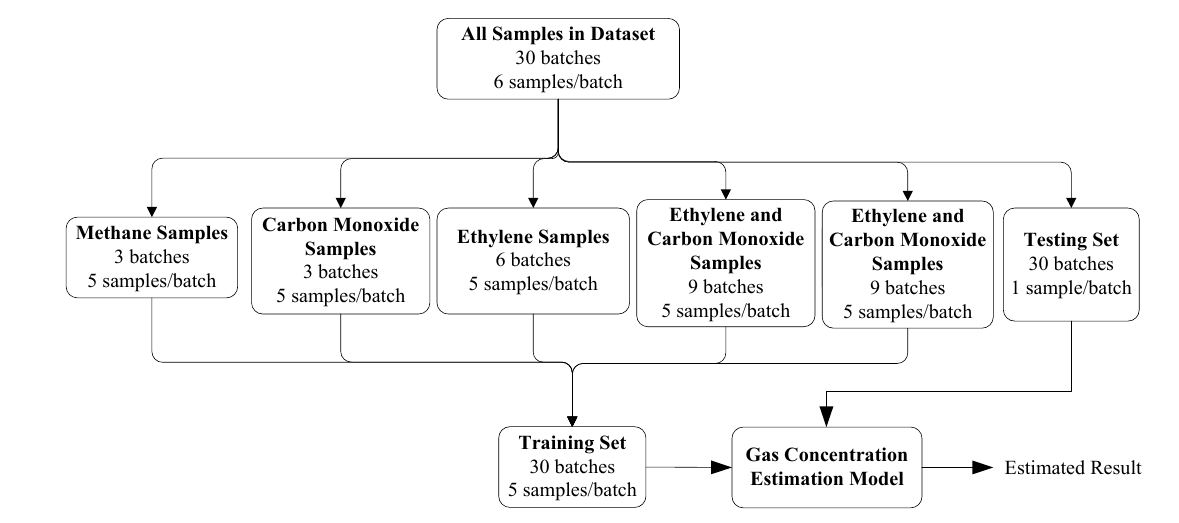
Figure 10. Full-sample selection strategy for estimating ethylene concentration.